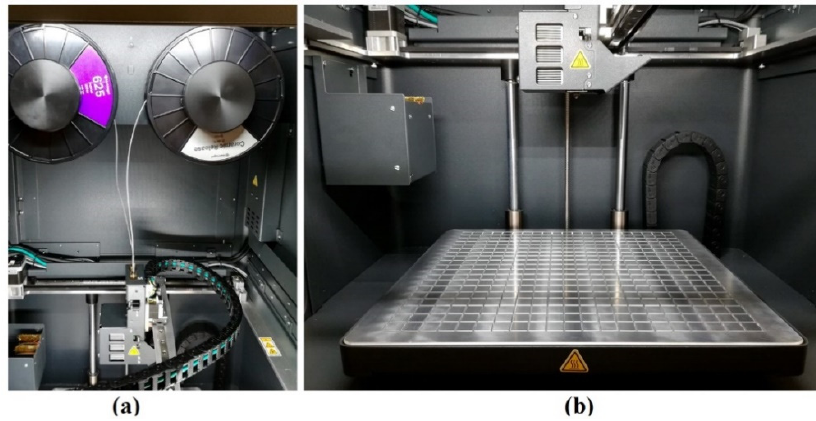
Figure 3. MetalX 3D printer. ( a ) Material storage chamber and ( b ) printing chamber.